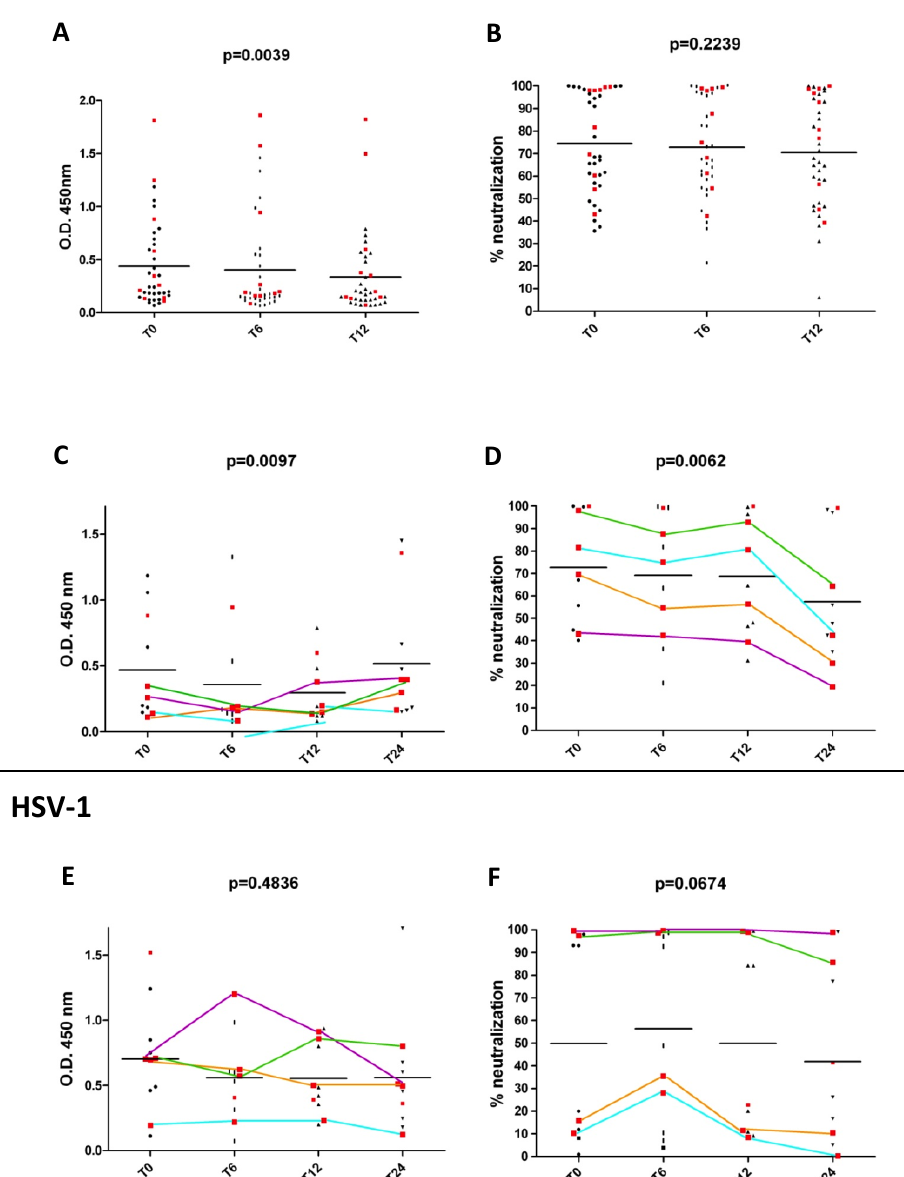
Figure 1. Scatterplots of the serum reactivity and neutralizing activity at different natalizumab infusion time points. The serum reactivity in ELISA against JC polyomavirus (JCPyV)/VP1 ( A ) and the corresponding anti-JCPyV neutralizing activity ( B ) are reported for all the 38 patients at baseline (T0), and after six (T6) and 12 (T12) monthly natalizumab infusions. The same parameters for the 11 patients followed up to 24 infusions (T24) are reported in ( C ) and ( D ); for these patients the serum reactivity in ELISA against HSV-1 viral particles ( E ) and the anti-HSV1 neutralizing activity ( F ) are also reported. The average values at each time point are depicted as black horizontal bars, and the resulting p values calculated by Friedman test are reported. All previously mitoxantrone-treated patients are marked with a red square ( (cid:4) ). The four patients with at least a 20% decrease of anti-JCPyV neutralizing activity between T0 and T24 are reported as colored lines; interestingly, the light blue-marked patient developed progressive multifocal leukoencephalopathy (PML) during natalizumab treatment (after the 34 th natalizumab infusion). It is important to realize that none of the patients underwent plasma exchange therapy.